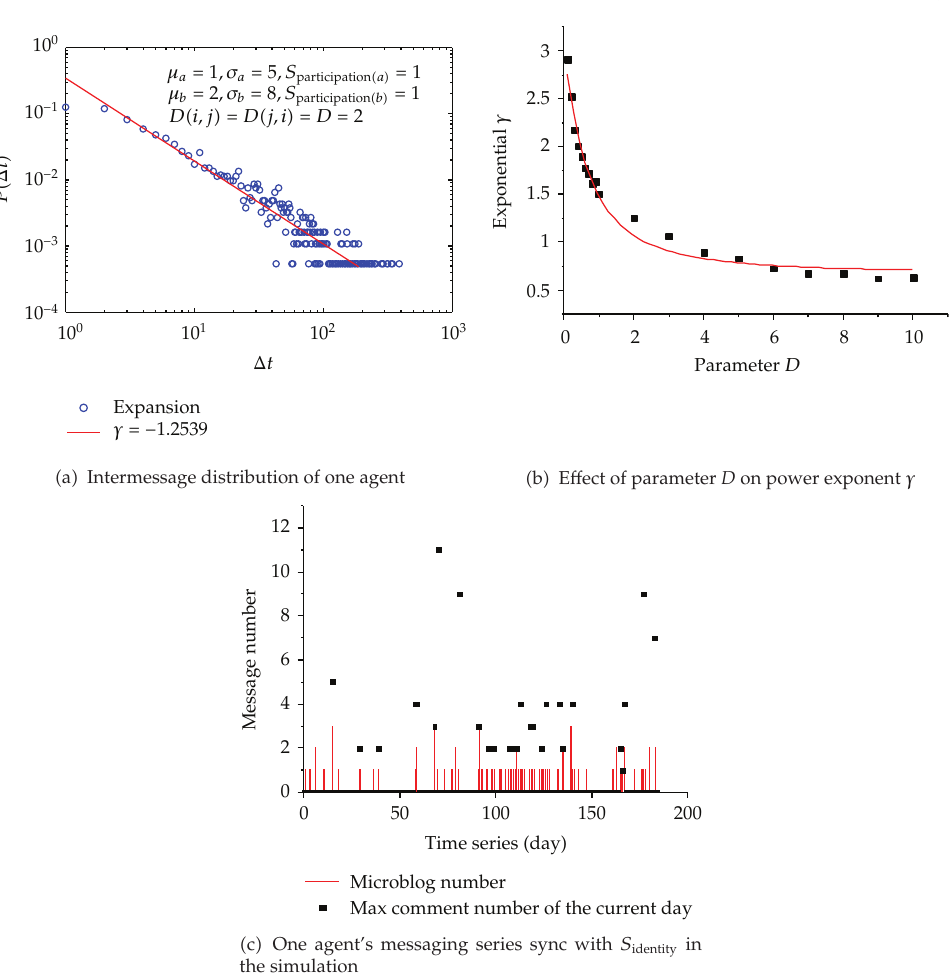
Figure 9: Simulation results with the two-agents